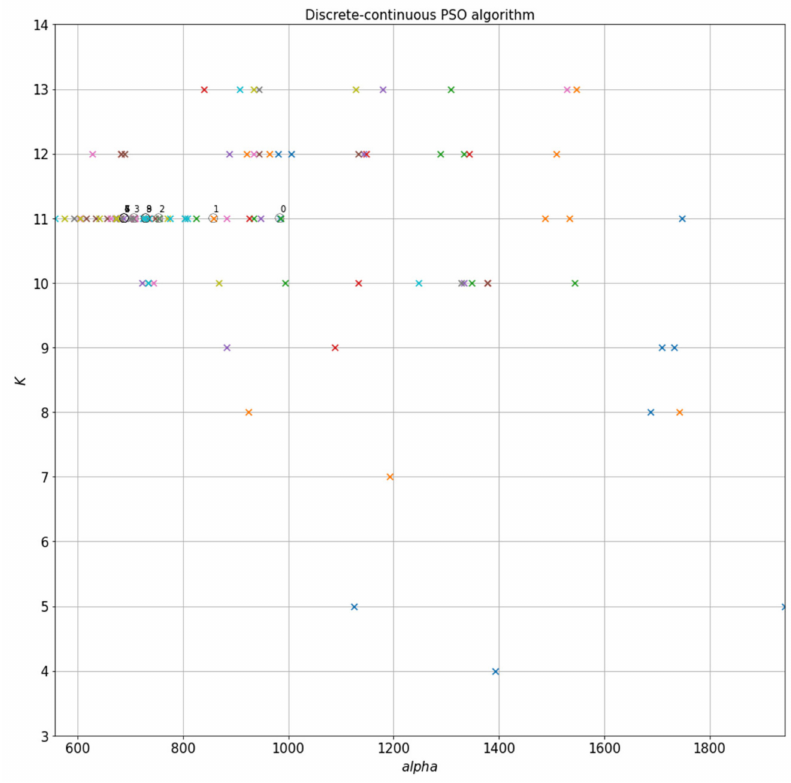
Figure 3. Convergence of discrete–continuous PSO